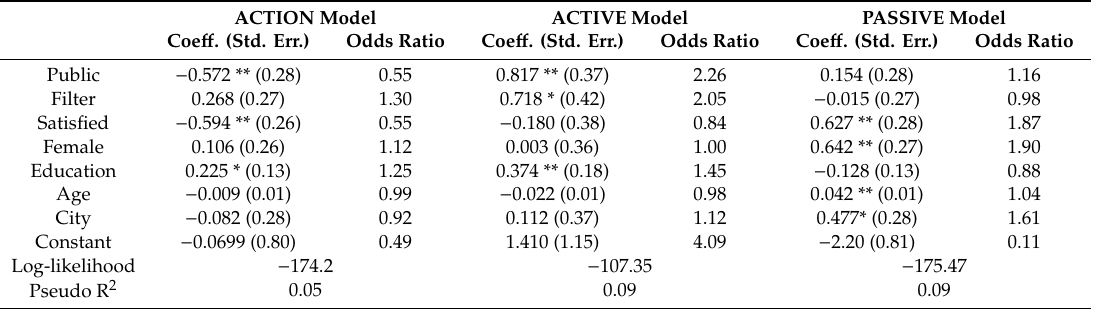
Table 4. Parameter estimates of the binary logit model explaining the factors that a ff ect respondent preferences for learning opportunities about water issues ( n =